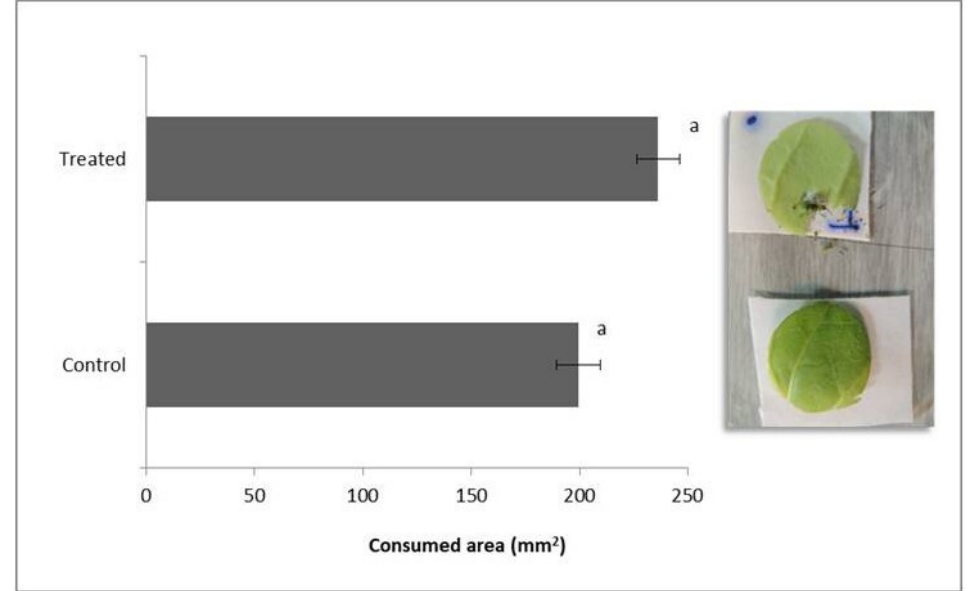
Figure 2. Leaf area consumed (mm 2 ) by Diabrotica speciosa adults fed with Beauveria bassiana colonized (treated) and non-colonized (control) tobacco plants. Bars with the same letters are not significantly different according to a Student’s t -test ( p <